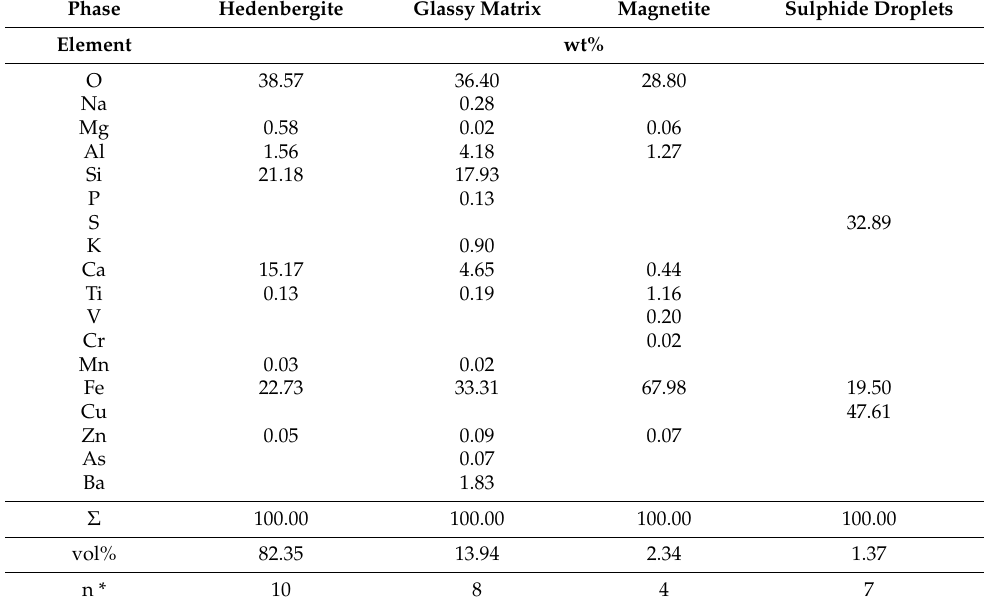
Table 2. Phase analysis of CSA using SEM-EDS.